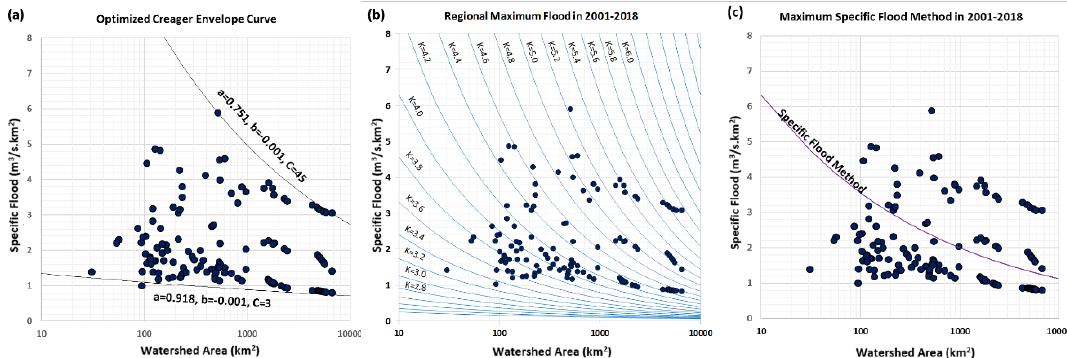
Figure 10. Specific flood for all events with applications of various regional maximum flood equations in 2001–2018. ( a ) Creager’s envelop curve, ( b ) Kovacs’ regional maximum flood, and ( c ) Korean regional maximum flood).